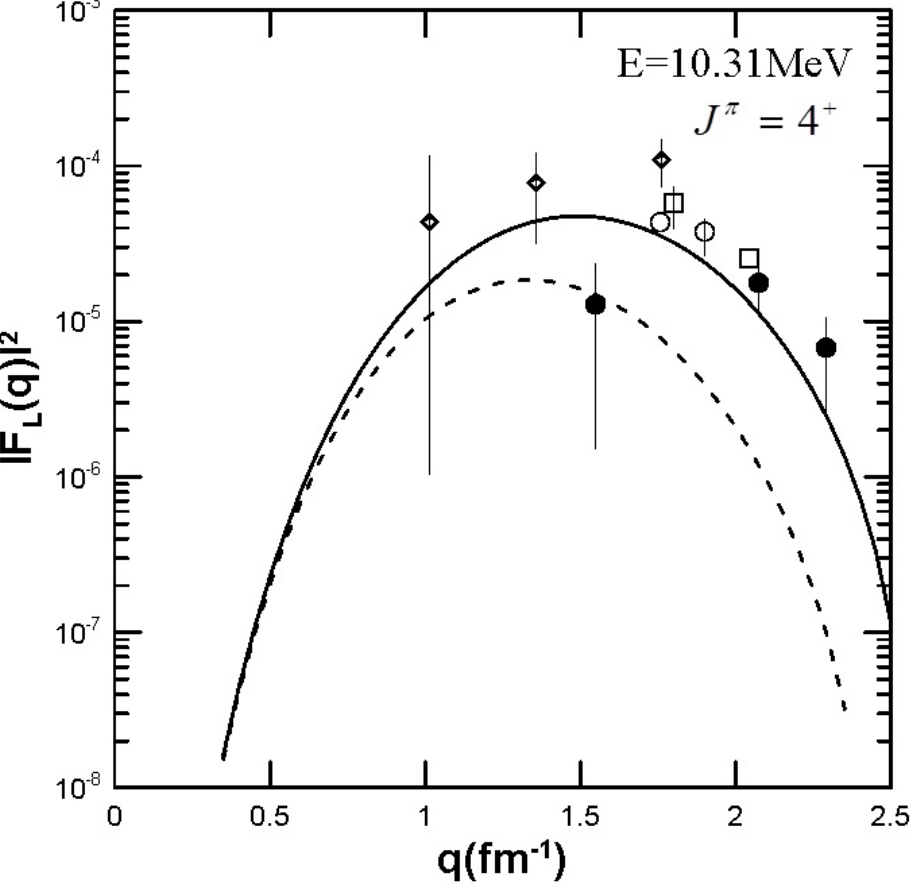
Fig. 4: Inelastic Coulomb 4 C form factors for the transition to the 14  (10.31 MeV) state. The dashed and solid curves are the calculated 4 C form factors without and with the inclusion of the effect of the SRC, respectively. The open circle, closed circle, open square and rhomb symbols are those of the experimental data taken from ref.